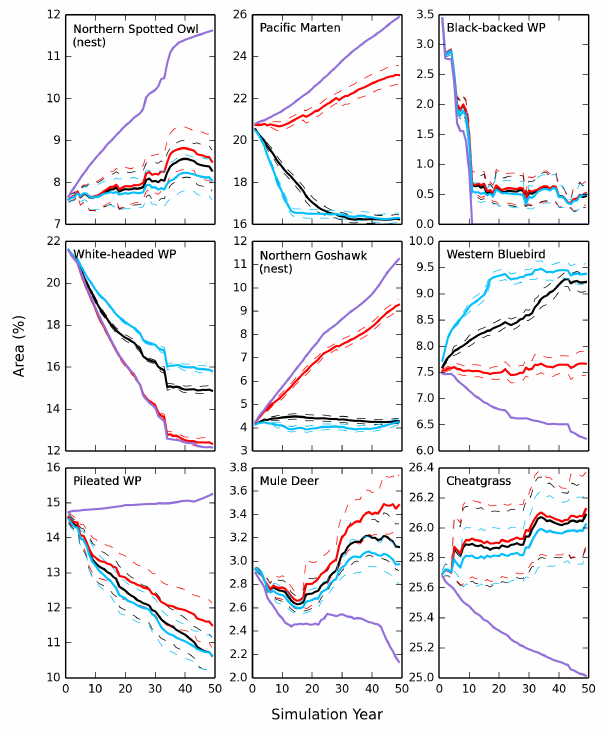
Fig. 11. Mean area of habitat for eight species of vertebrates and one plant of interest over time for different management scenarios. Broken lines indicate corresponding 95% confidence intervals for 15